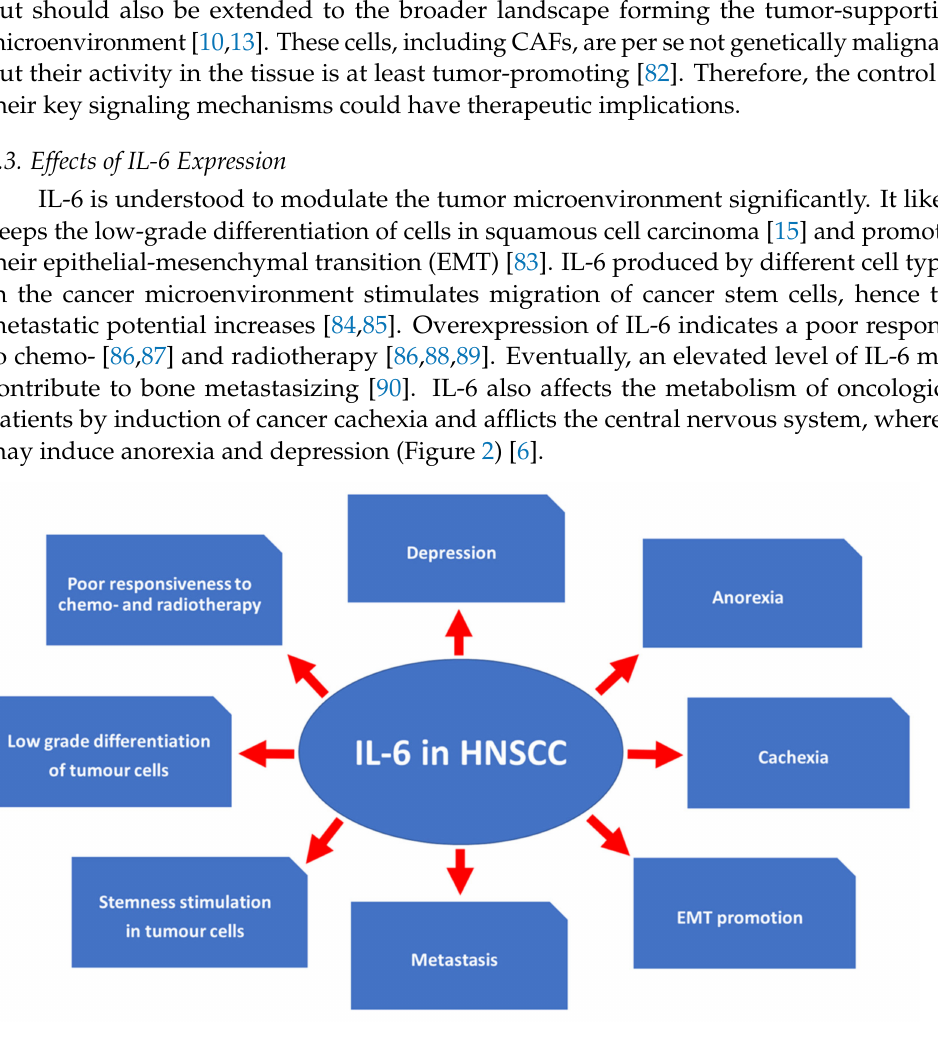
Figure 2. Effects of IL-6 expression in HNSCC [6,15,83–86,88–90]. The role of the IL-6 cytokine is multifaceted in HNSCC. In the brain, IL-6 can be linked to the onset of depression and can also cause food intake disorders (anorexia), leading to wasting (cachexia). At the cellular level, IL-6 promotes epithelial-to-mesenchymal transition, which leads to the formation of metastatic lesions. Maintenance of low differentiation is associated with certain stemness features in tumor cells, predisposing to a poor response to chemo- and radiotherapy. However, many of these factors can further potentiate each other